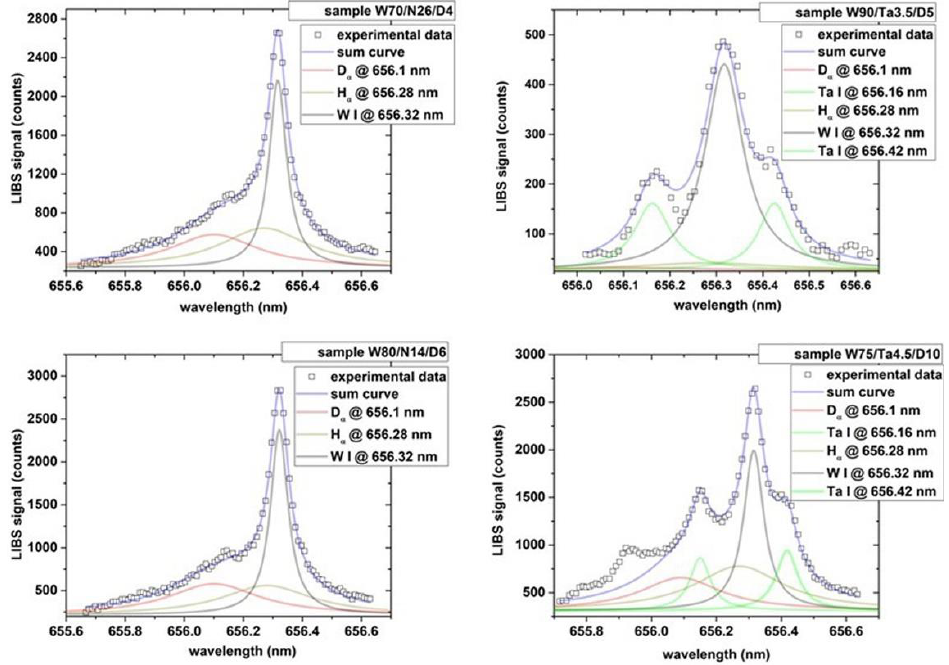
Figure 5. Fits of the experimental line-shapes of the four samples in the D α /H α spectral region. Each spectral component of W, Ta, D, H and their sum curve is shown in different colors.